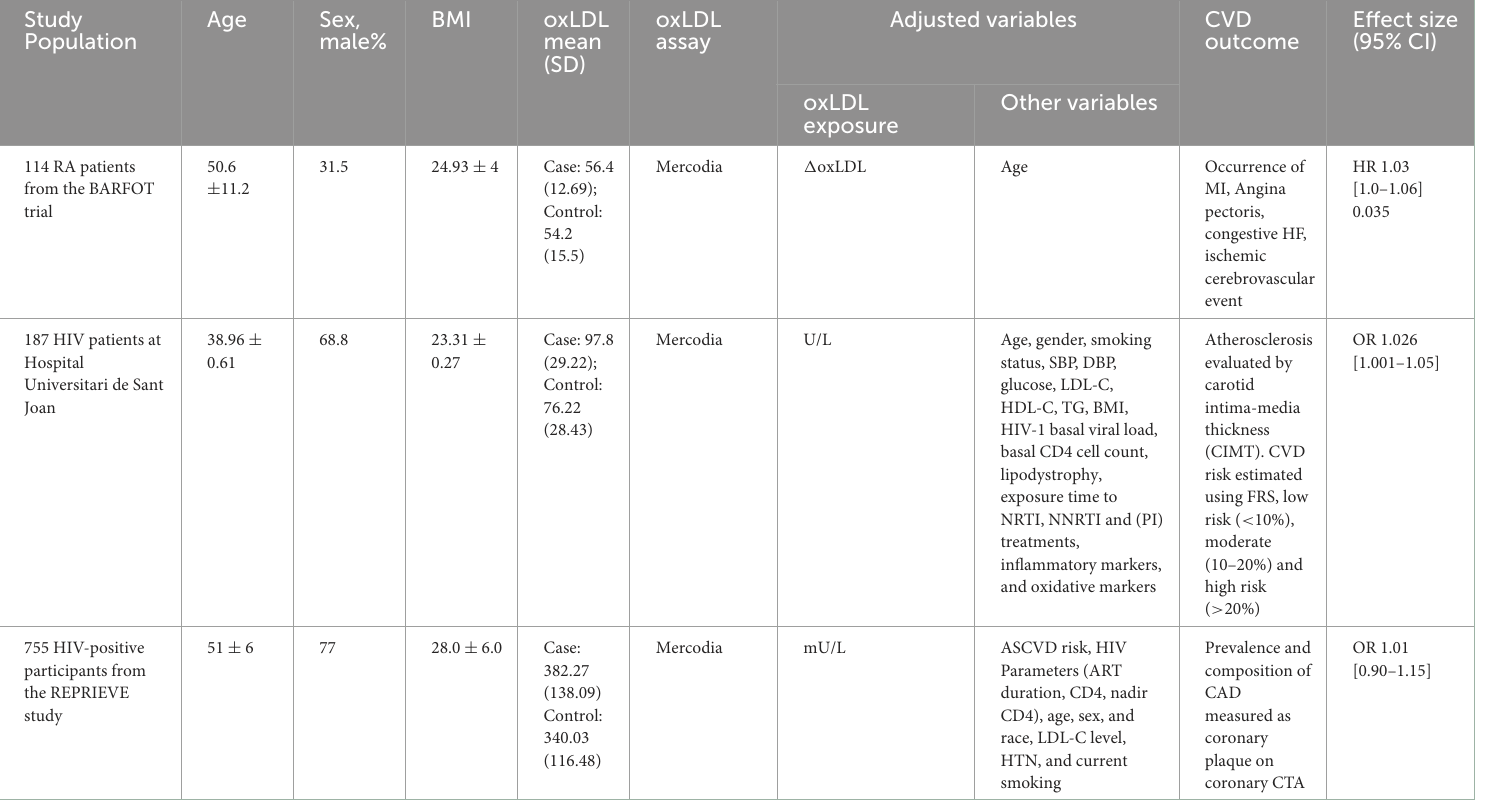
TABLE 1 Baseline characteristics of studies included in the